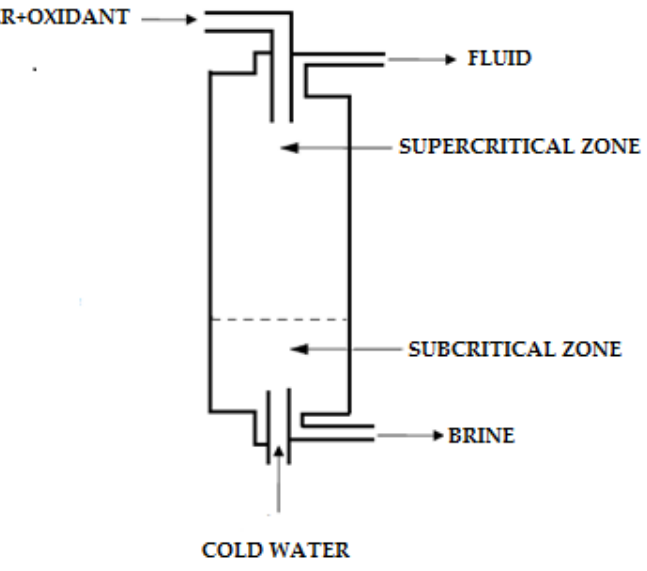
Figure 9. Modar SCWO tank type reactor [86].